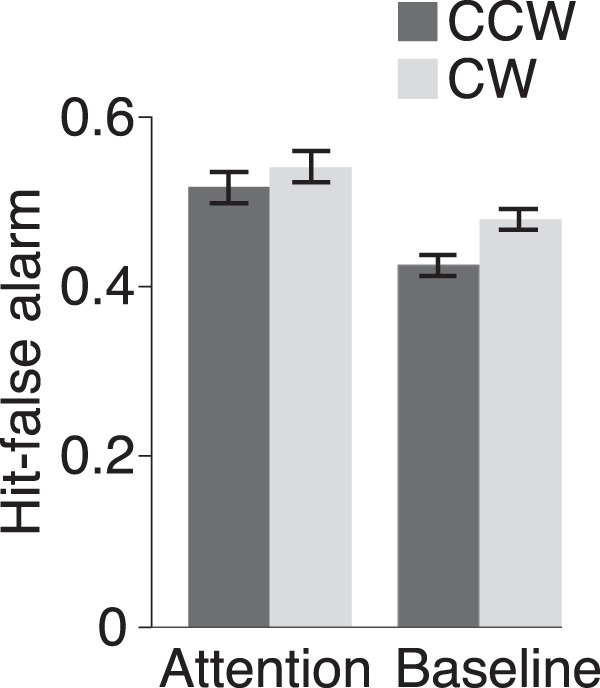
Behavioral results in the scanner. Error bars indicate ± within-subject SEM following the method of Cousineau (2005).